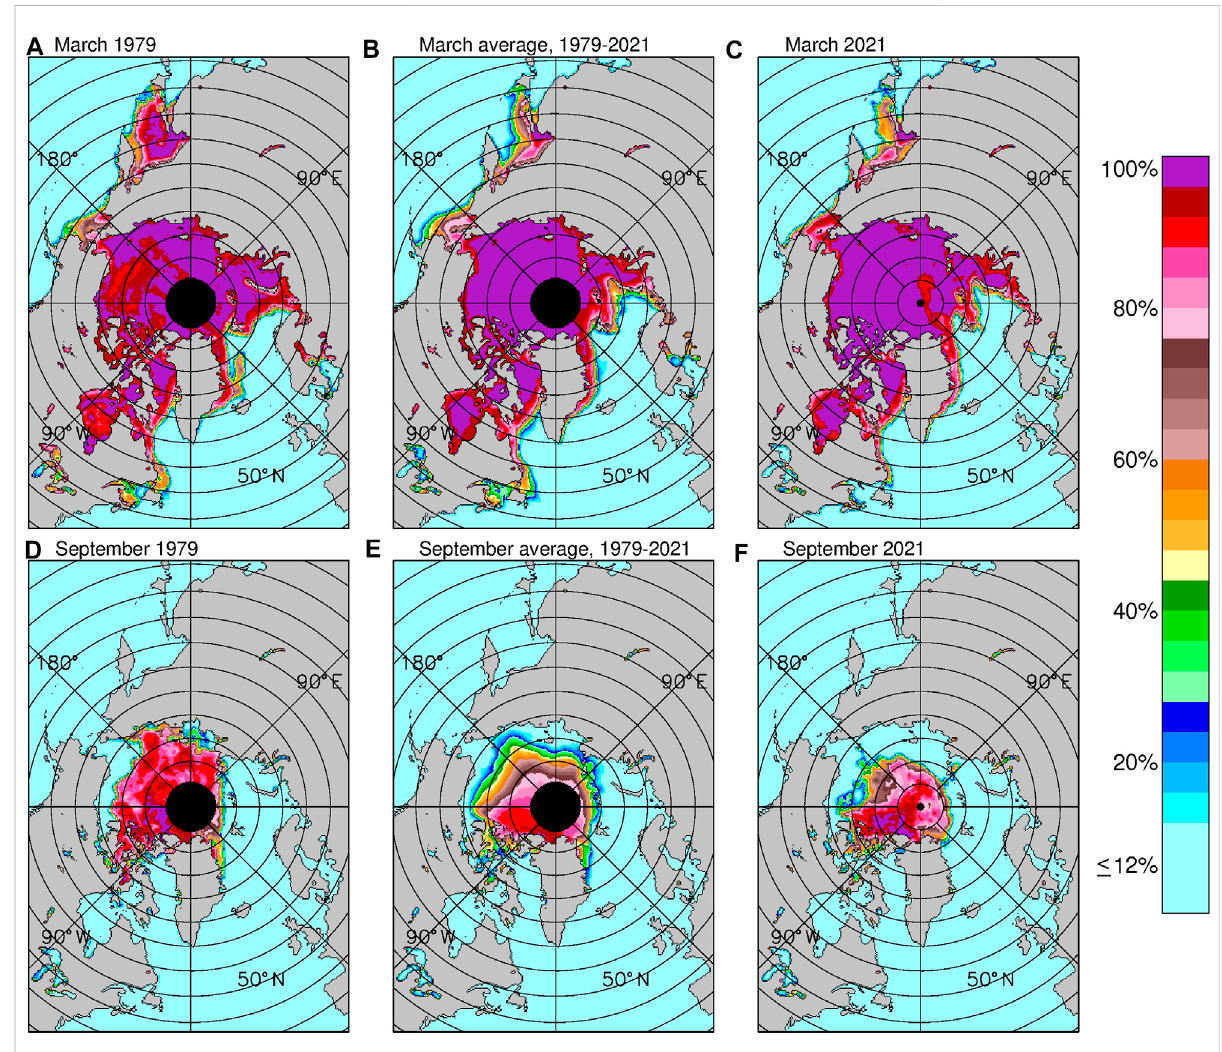
FIGURE 1 Average Arctic sea ice concentrations for: (A) March 1979, (B) the 43-year March average, 1979 – 2021, (C) March 2021, (D) September 1979, (E) the 43-year September average, 1979 – 2021, (F) September 2021. The prominent black circular region centered on the North Pole in the 1979 and 1979 – 2021imagesrepresentsmissingdataandre fl ectsthefactthattheorbitoftheNimbus7satellite,obtaining thedataforthe fi rst8.6 yearsofthe 43-year record, did not bring the satellite close enough to the Pole to allow data collection poleward of 84.6 °